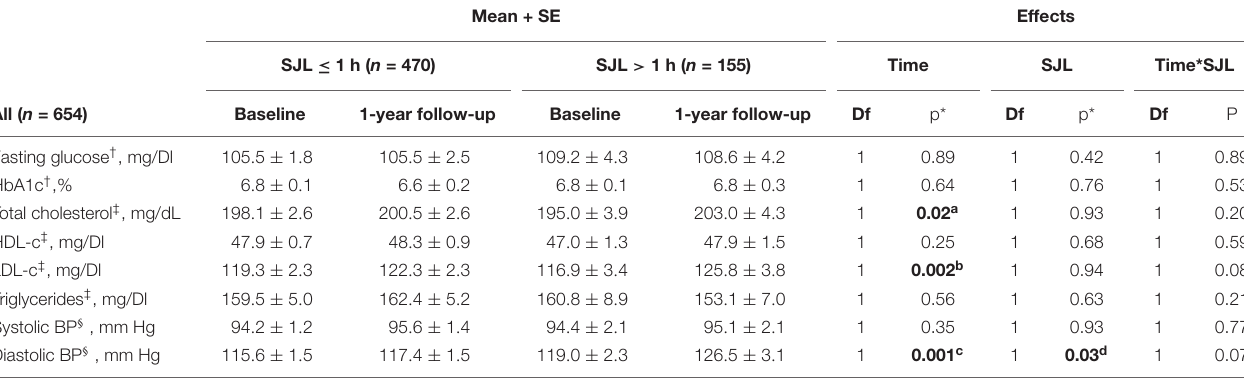
TABLE 2 | Estimated measurements of metabolic parameters according to social jetlag ( n = 625).